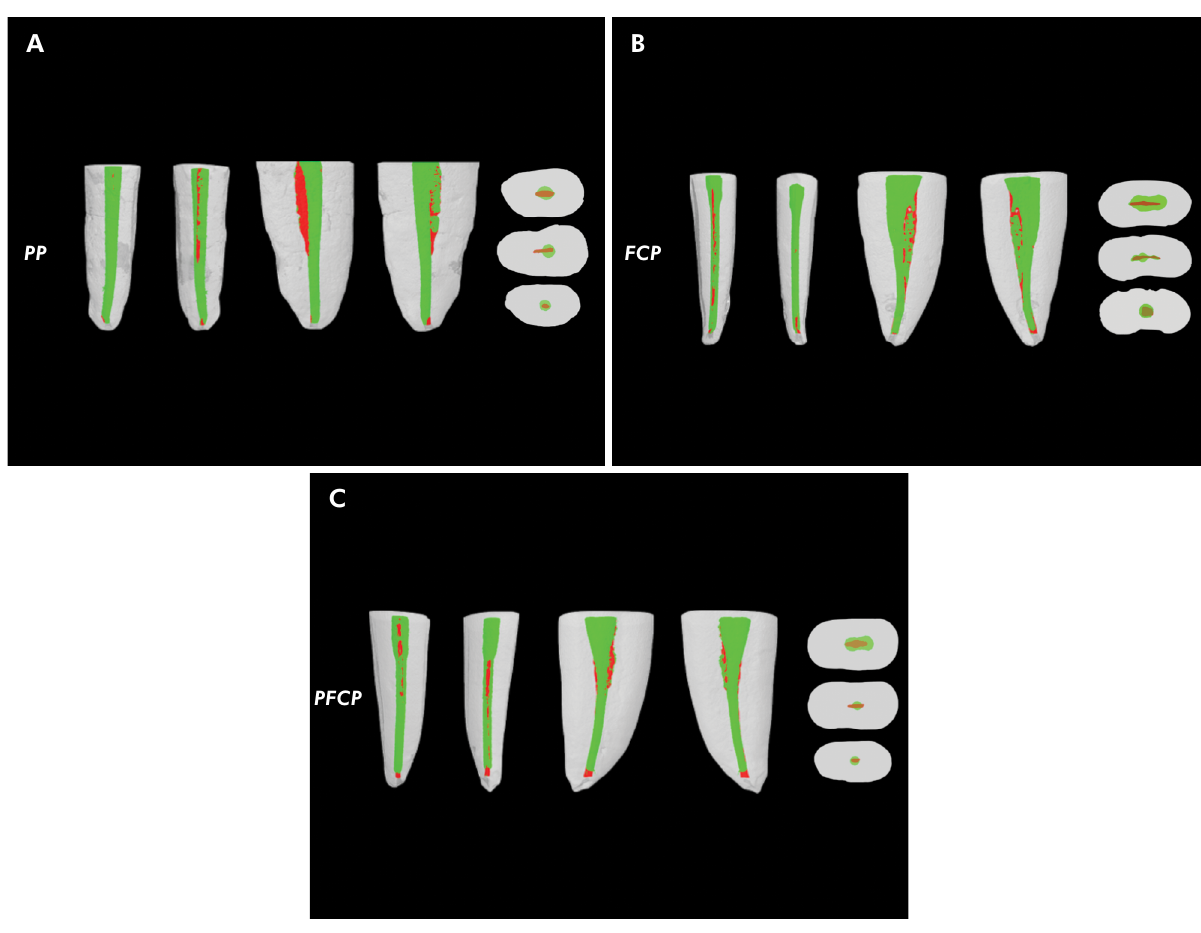
Figure 2. (A) Representative reconstructions of the superimposed specimens before (red) and after (green) endodontic instrumentation in PP. Front and side views (buccal, lingual, mesial, and distal). Representative cross-sections of the superimposed flattened/oval- shaped mandibular incisors before (red) and after (green) endodontic instrumentation in each experimental group at the coronal, middle, and apical thirds. (B) Representative reconstructions of the superimposed specimens before (red) and after (green) endodontic instrumentation in FCP – front and side views (buccal, lingual, mesial, and distal). Representative cross-sections of the superimposed flattened/oval-shaped mandibular incisors before (red) and after (green) endodontic instrumentation in each experimental group at the coronal, middle, and apical thirds. (C) Representative reconstructions of the superimposed specimens before (red) and after (green) endodontic instrumentation in PFCP. Front and side views (buccal, lingual, mesial, and distal). Representative cross-sections of the superimposed flattened/oval-shaped mandibular incisors before (red) and after (green) endodontic instrumentation in each experimental group at the coronal, middle, and apical